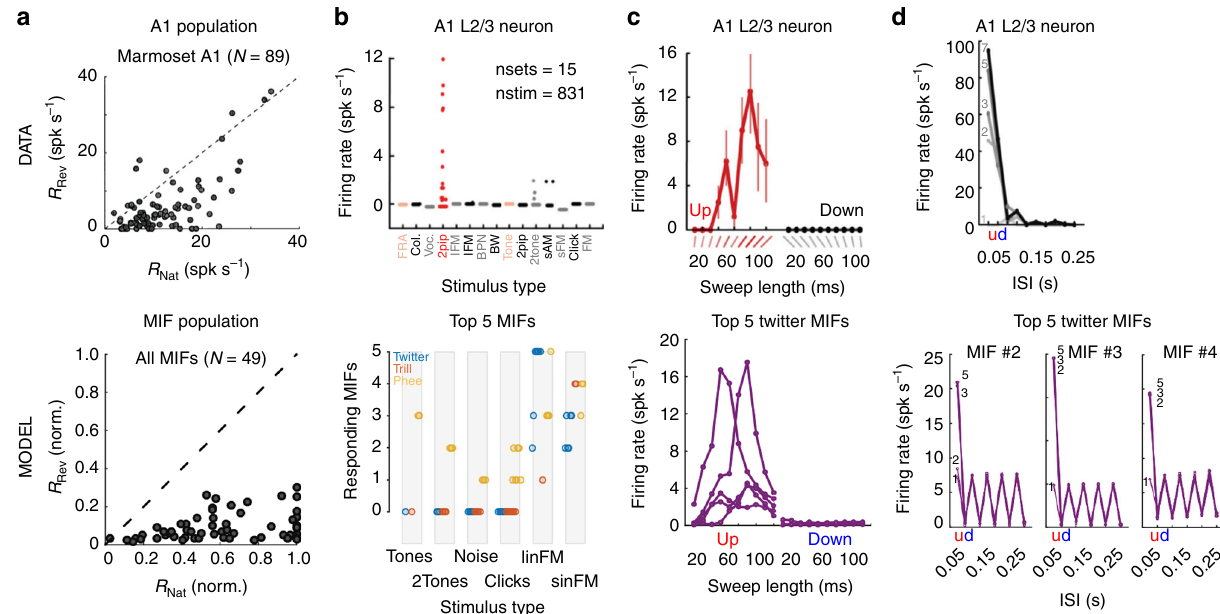
Fig. 8 Predictions of putative MIF-neuron tuning properties match cortical data. ( a – d , top row) Neural data from marmoset A1. ( a – d , bottom row) Model predictions. ( a -top) Preference of marmoset A1 responses for natural twitters over time-reversed twitters. ( a -bottom) Preference of model MIF neurons for natural calls over reversed calls. ( b -top) Sparse responses of marmoset A1 L2/3 neuron. ( b -bottom) Sparse responses of MIF neurons. The number of MIF neurons showing responses to the stimulus categories on the x -axis are plotted. Colors correspond to call type (blue — twitter, red — trill, yellow — phee). ( c - top) Marmoset A1 L2/3 neuron tuned to upward lFM sweeps of a speci fi c length (~80 ms). Error bars correspond to ±1 SD. ( c -bottom) Twitter MIF neurons show similar tuning. ( d -top) Marmoset A1 L2/3 neuron that does not respond to single lFM sweeps but shows tuning to trains of upward lFM sweeps with 50 ms inter-sweep interval. Grayscale corresponds to the number of lFM sweeps in the train. ( d -bottom) Three of the top 5 twitter MIFs showed similar tuning for lFM sweep trains. a -top reproduced from Wang and Kadia (2001), b – d top reproduced from Sadagopan and Wang